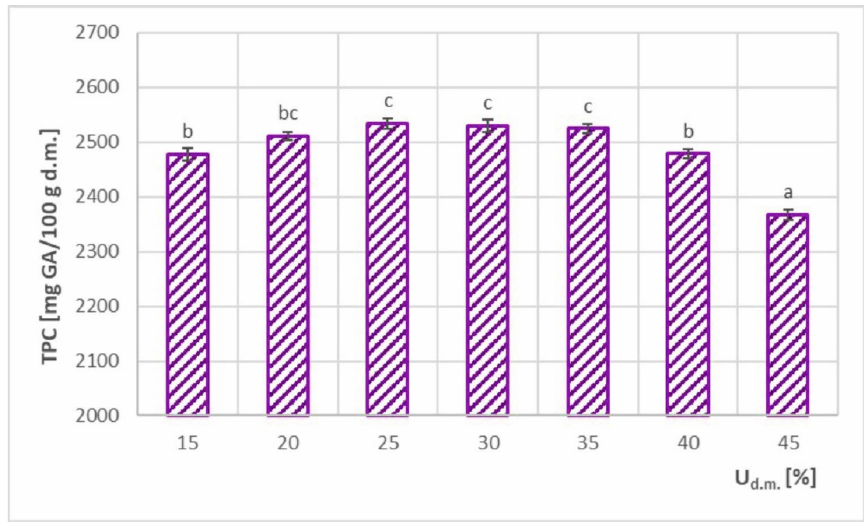
Figure 10. Total polyphenol content (TPC) in spray-dried chokeberry juice with different dry matter content in the feed solution (U d.m. ); (a, b, c — different letters show significant differences between mean values ( p ≤ 0.05)).